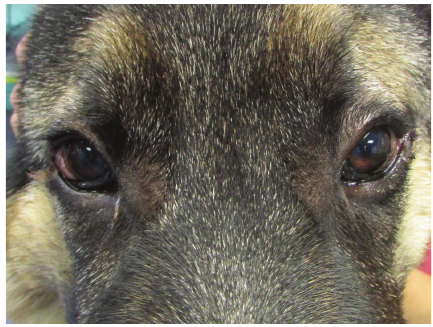
Figure 6: Case 1 appearance three month after surgery. No sign of discomfort is observed.